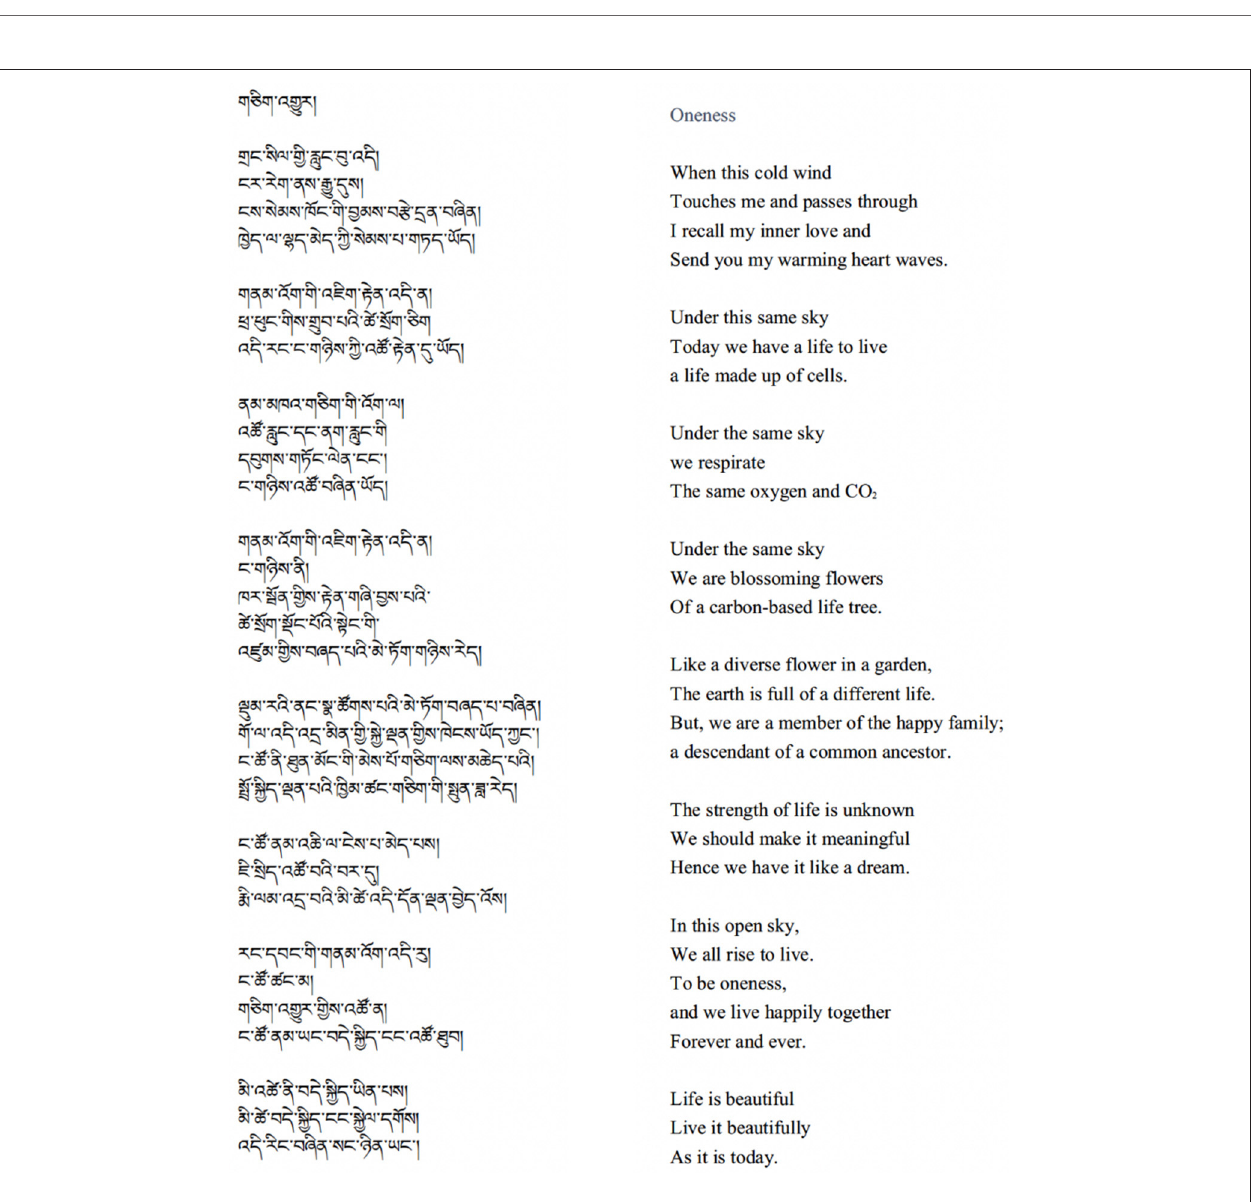
FIGURE 1 | Poem authored by Stanzin Wangdan, one of the 2017–2019 Tenzin Gyatso Scholars who completed a 2-year science residency at Emory